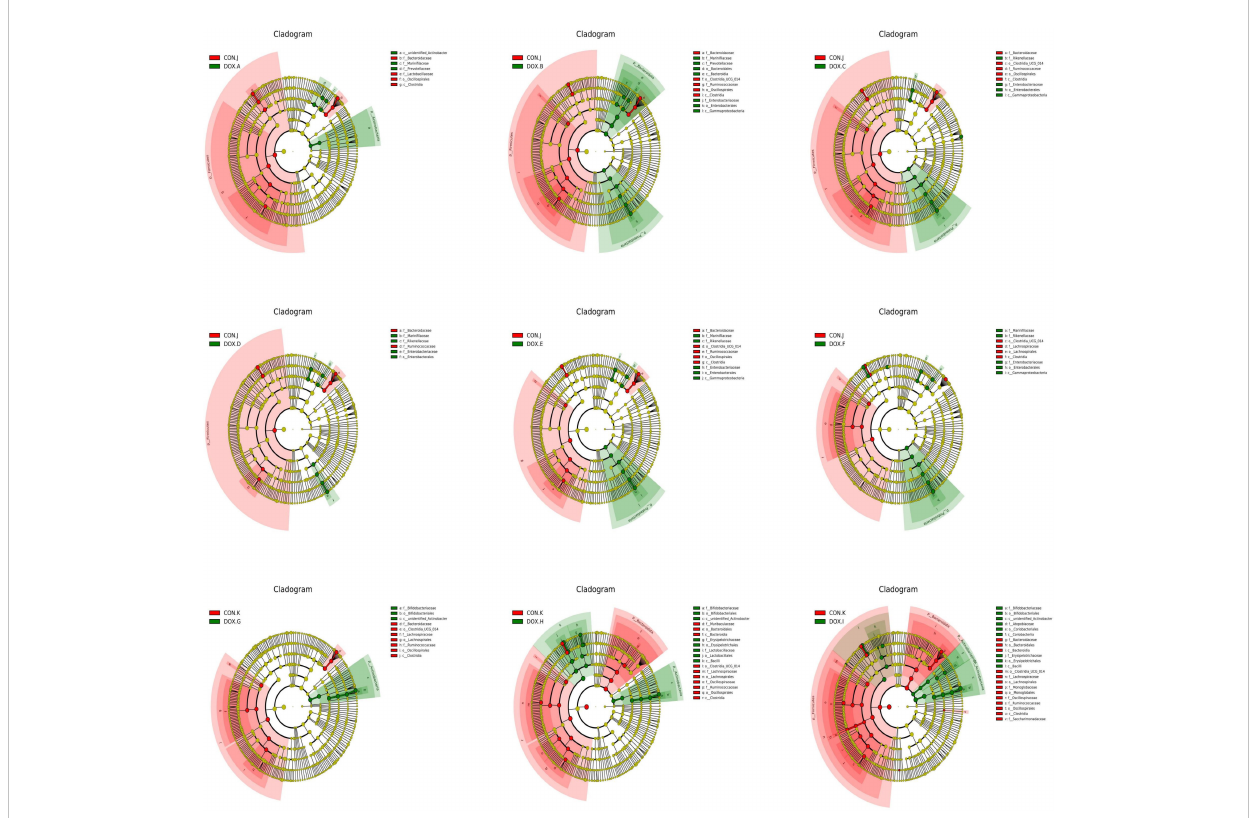
FIGURE 8 Histogram analyzed by LEfSe (LDA = 4.0, P < 0.05) showing the LDA scores for differentially abundant genera in CON group and DOX group. Circles radiating from inside to outside indicate phylogenetic levels from kingdom to genus. Nodes with different colors indicate microbial taxa that are enriched in the corresponding groups and have signi fi cant differences between groups, and the size of node diameter is proportional to the relative abundance size; yellow nodes indicate microbial taxa that have no signi fi cant differences between groups. CON, control; DOX, doxorubicin; LDA, linear discriminant analysis; LEfSe, linear discriminant analysis effect size. n =